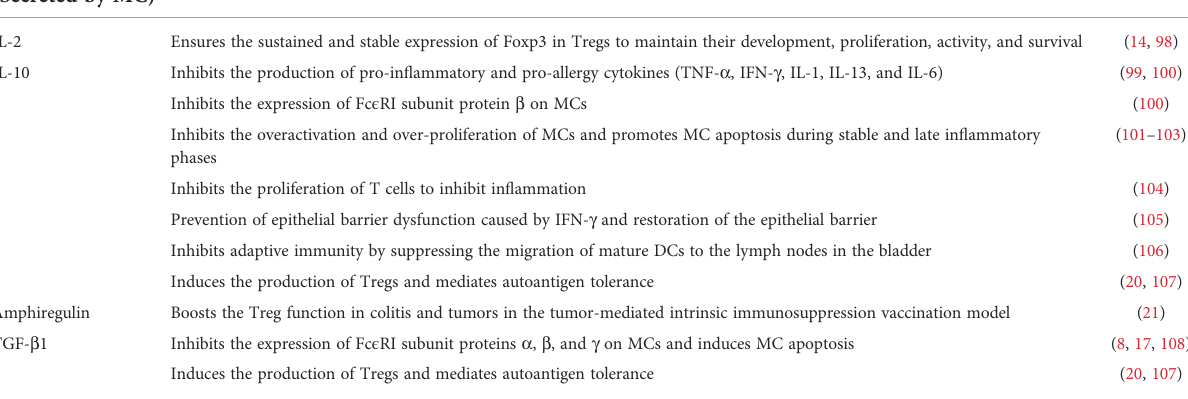
TABLE 1 The immunoregulatory effect of